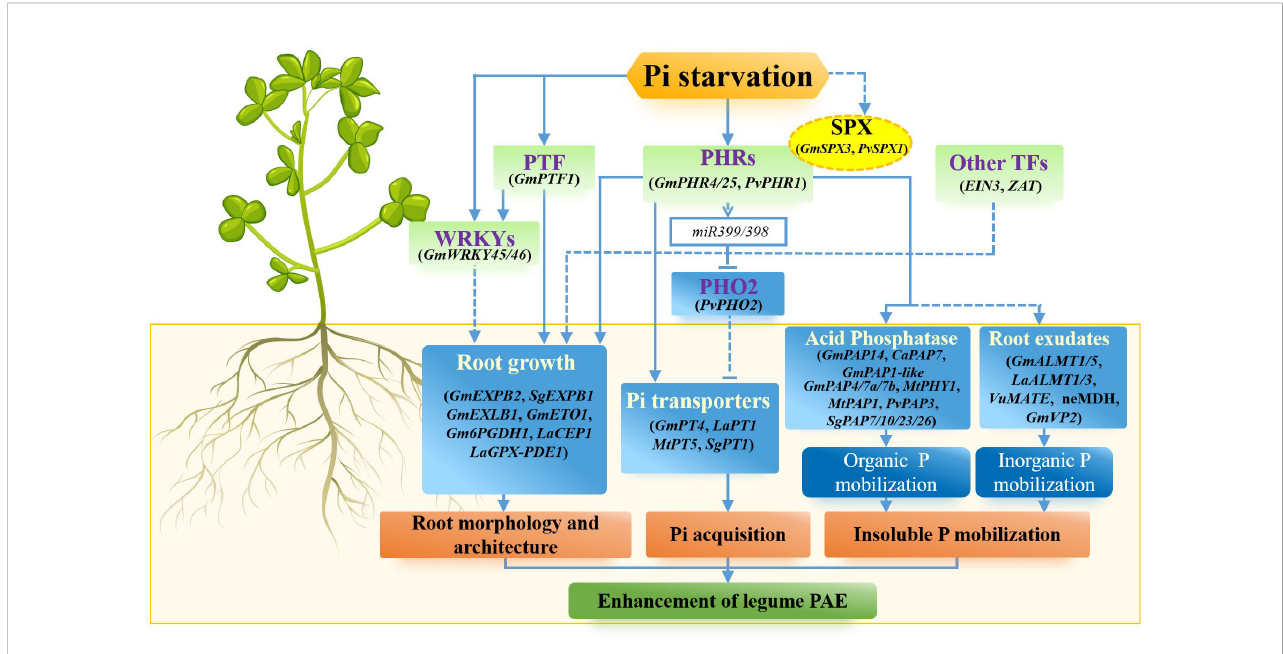
FIGURE 1 Strategies for improving P acquisition ef fi ciency through gene regulation in legumes. In legumes, P acquisition ef fi ciency can be achieved by remodeling of root morphology and architecture, inducing high-af fi nity Pi transporters, increasing root exudates to facilitating P mobilization, and activating Pi signaling network. A variety of Pi starvation-induced (PSI) genes have been implicated in improving P acquisition ef fi ciency in legumes. These are related to root growth, Pi uptake, insoluble P mobilization and Pi signaling